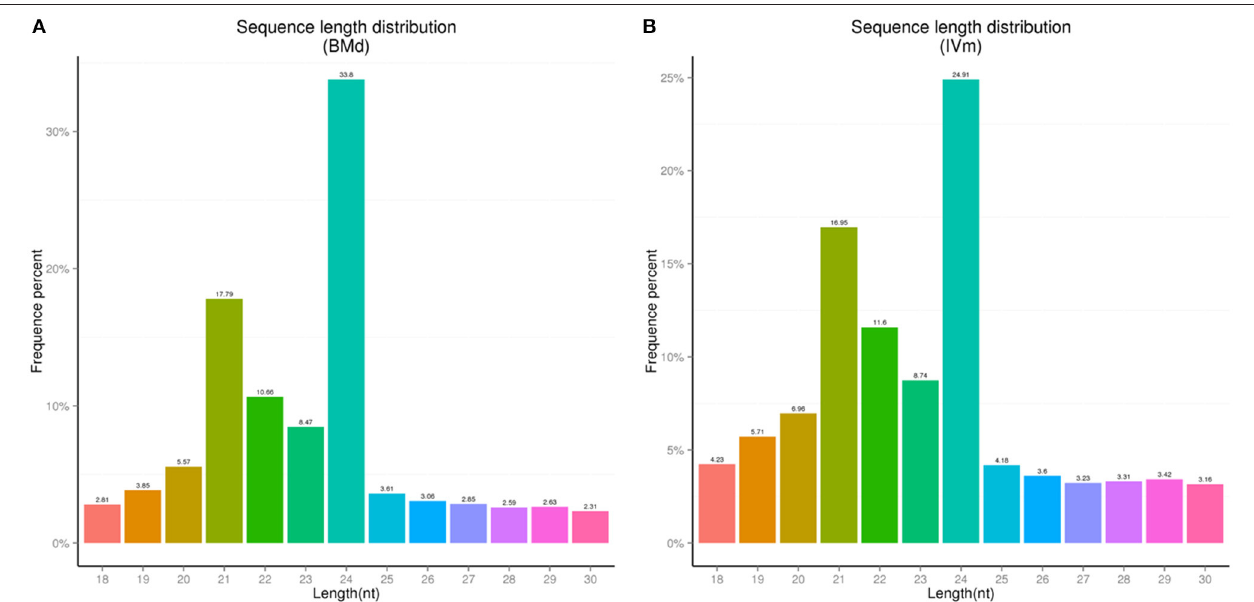
TABLE 1 | Reads mapped to the selected miRNAs/pre-miRNAs in miRbase. Groups